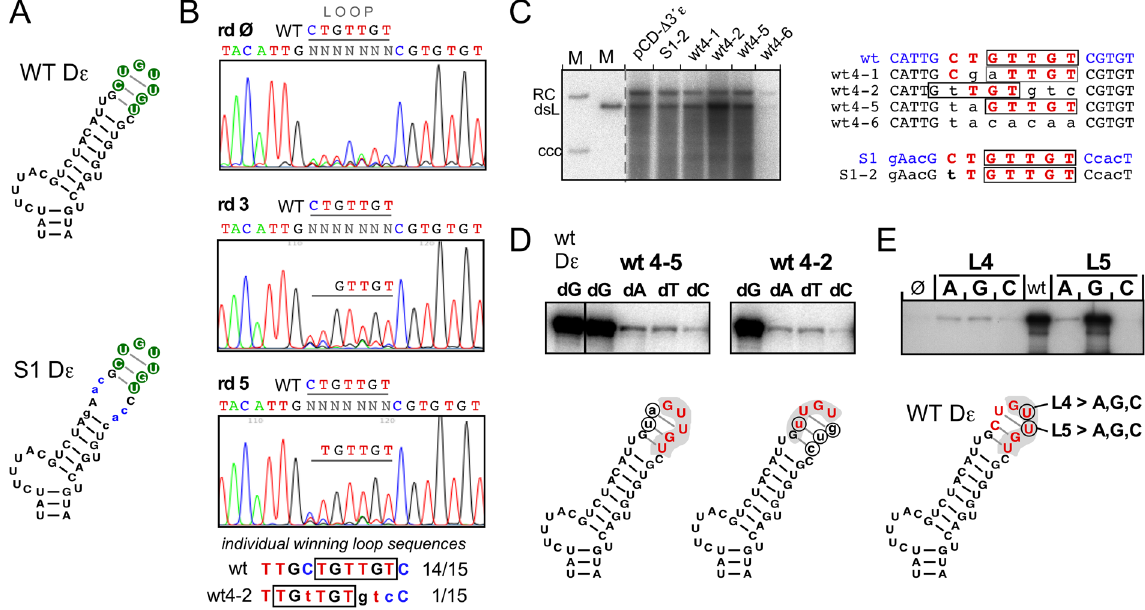
Figure 4. In-cell SELEX reveals the importance of the GUUGU motif in the apical loop of wt-D ε . SELEX experiments were performed using a starting pool carrying a randomized classical loop sequence in the context of wt-D ε . ( A ) Positions of the randomized loop sequences in wt-D ε and variant S1. Targeted nt are shown as white letters with green background. ( B ) Pool sequencing chromatograms. Note the rapid emergence of the GUUGU motif already after round 3. After round 5, 14 of 15 individual clones carried the wt-loop sequence, one (wt4-2; already seen after round 4) still contained the TGTTGT motif though a shifted position, as shown at the bottom. ( C ) Replication capacity of individual round 4 sequences. Clone wt4-6 with a completely non-wt loop sequence replicated poorly; all others replicated at near wt-levels, including clone S1–2 derived from the next SELEX experiment. Note the common presence of the GUUGU motif (aUUGU in clone wt4-1) though at a shifted position in clone wt4-2. ( D ) No impact of GUUGU-adjacent residues on dNTP specificity during in vitro priming. Variants wt4-5 (non-wt nt at loop positions 1 and 2) and wt4-2 (shifted GUUGU motif) were analyzed by miniDP in vitro priming assays with either dGTP, dATP, dTTP or dCTP as only dNTP. Both exerted a strong preference for the authentic dG. ( E ) Strong impact of mutations within the GUUGU motif on priming- activity. The central U residues at loop positions L4 (U2590) and L5 (U2591) were individually mutated as indicated, then analyzed by miniDP priming assays with